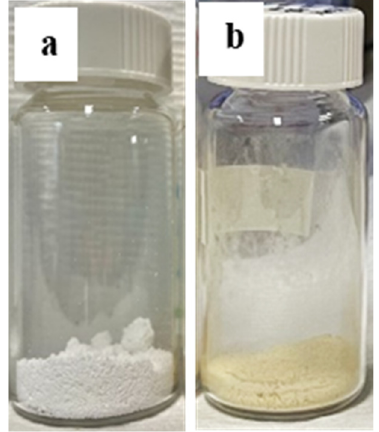
Figure 4. Photographs of ( a ) rutile TiO 2 and ( b ) ball-milled Fe/TiO 2 ⁻ 7.